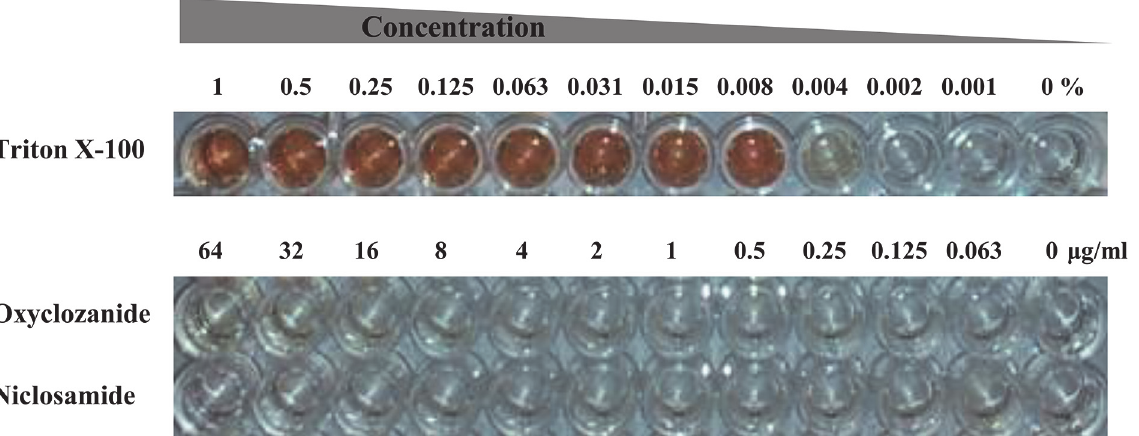
Fig 6. Hemolytic activity of niclosamide and oxyclozanide. Sheep erythrocytes were treated with serial dilutions of Triton X-100 (.001 – 1%), oxyclozanide and niclosamide (0.063 – 64 μ g/ml)